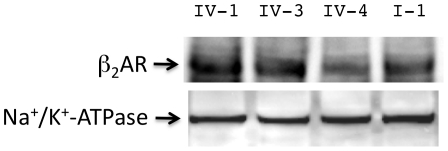
Western blots confirm the radioligand binding method for ranking expression.Monoclonal antibody to a non-polymorphic region of the β2AR protein was utilized to confirm the radioligand binding method for ranking expression phenotypes of the β2AR haplotypes. Shown is a single experiment revealing higher expression of haplotypes IV-1 and IV-3 compared to IV-4 and VI-2 β2AR protein at the expected molecular weight (∼79 kDa). These results are consistent with those from radioligand binding of Figure 1. The control antibody was to Na+/K+-ATPase, a cell membrane protein.